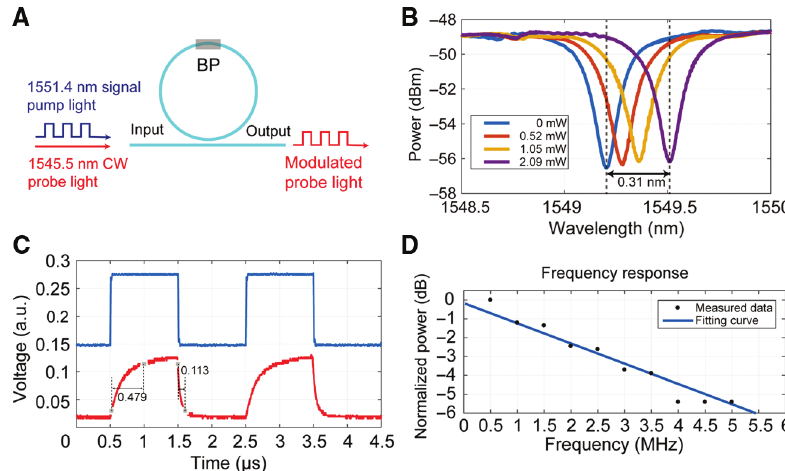
Figure 3: The schematic diagram and results for pumping in waveguides. (A) Sketch of the modulator when applied pump light and probe light both coupled in the waveguide. (B) Transmission spectra of the output when coupled in different powers of the pump light. (C) Measured waveform of the probe light (red) when the pump light (blue) is modulated with a 500 kHz square waveform signal. (D) Frequency response of the modulator, where the blue line is the fitting curve of measured